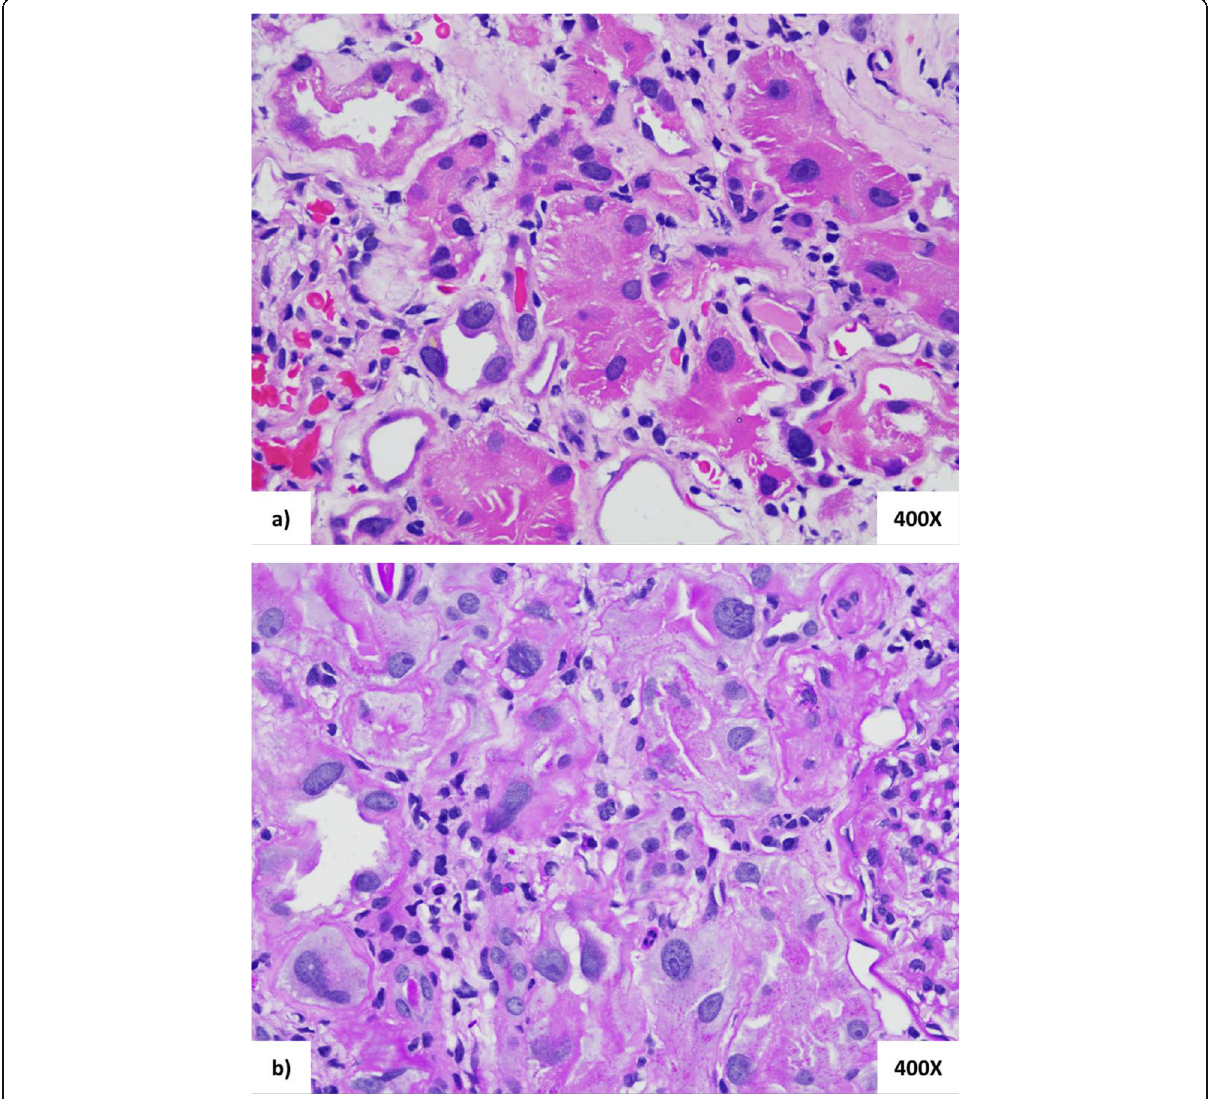
Fig. 1 a H&E and b PAS stains demonstrate large, hyperchromatic and pleomorphic nuclei, prominent nucleoli in the absence of